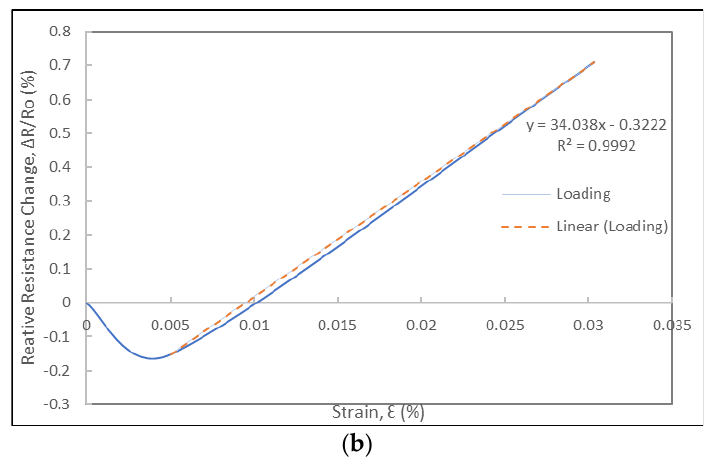
Figure 9. Electromechanical response of the same foil strain gauge prototype under subsequent cyclic loading at a displacement rate of 300 µ m/min: ( a ) Strain and relative resistance change histories during three loading-unloading cycles. ( b ) Relative resistance change versus strain curve of first loading cycle and corresponding gauge factor.